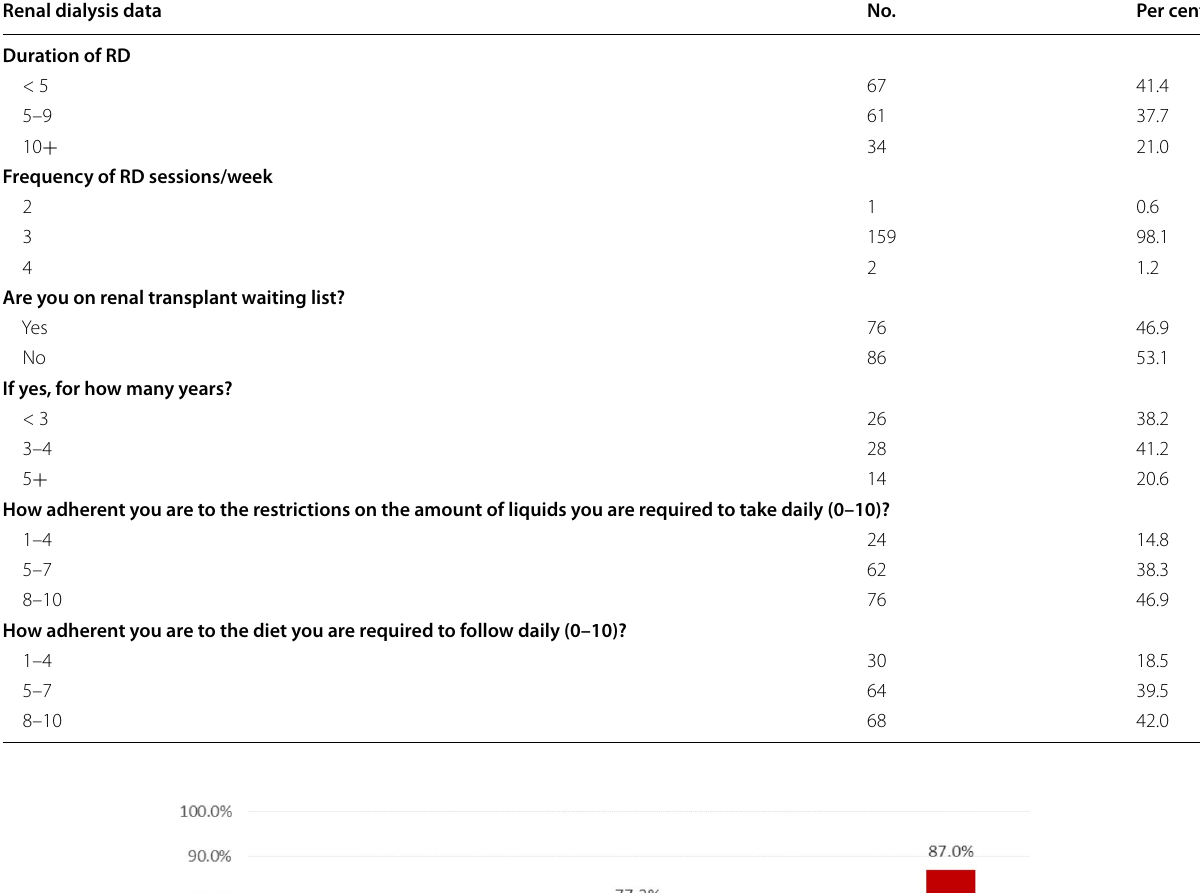
Table 2 Renal dialysis data among study patients, Saudi Arabia